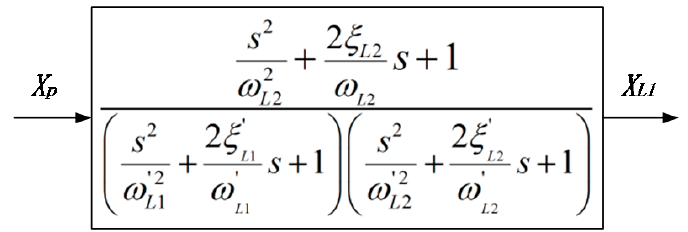
Figure 7. The normalized control block diagram of the thrust vector dynamics.